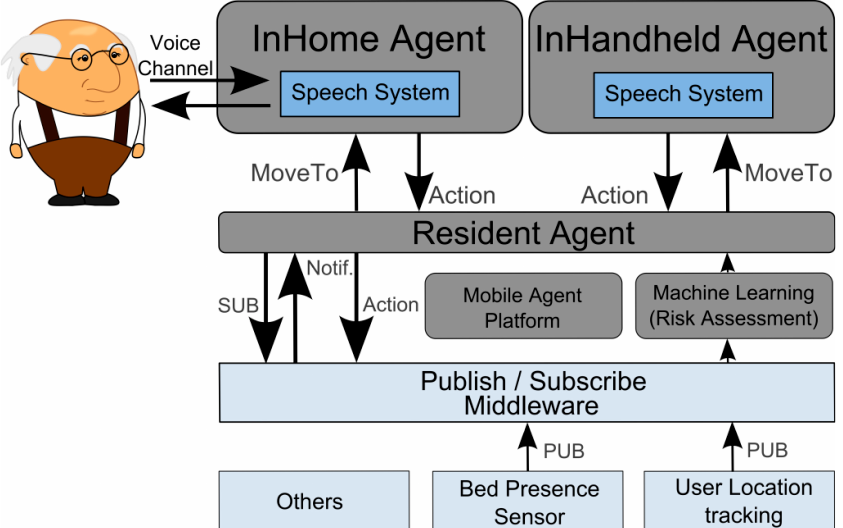
Figure 3. The Virtual Butler sub